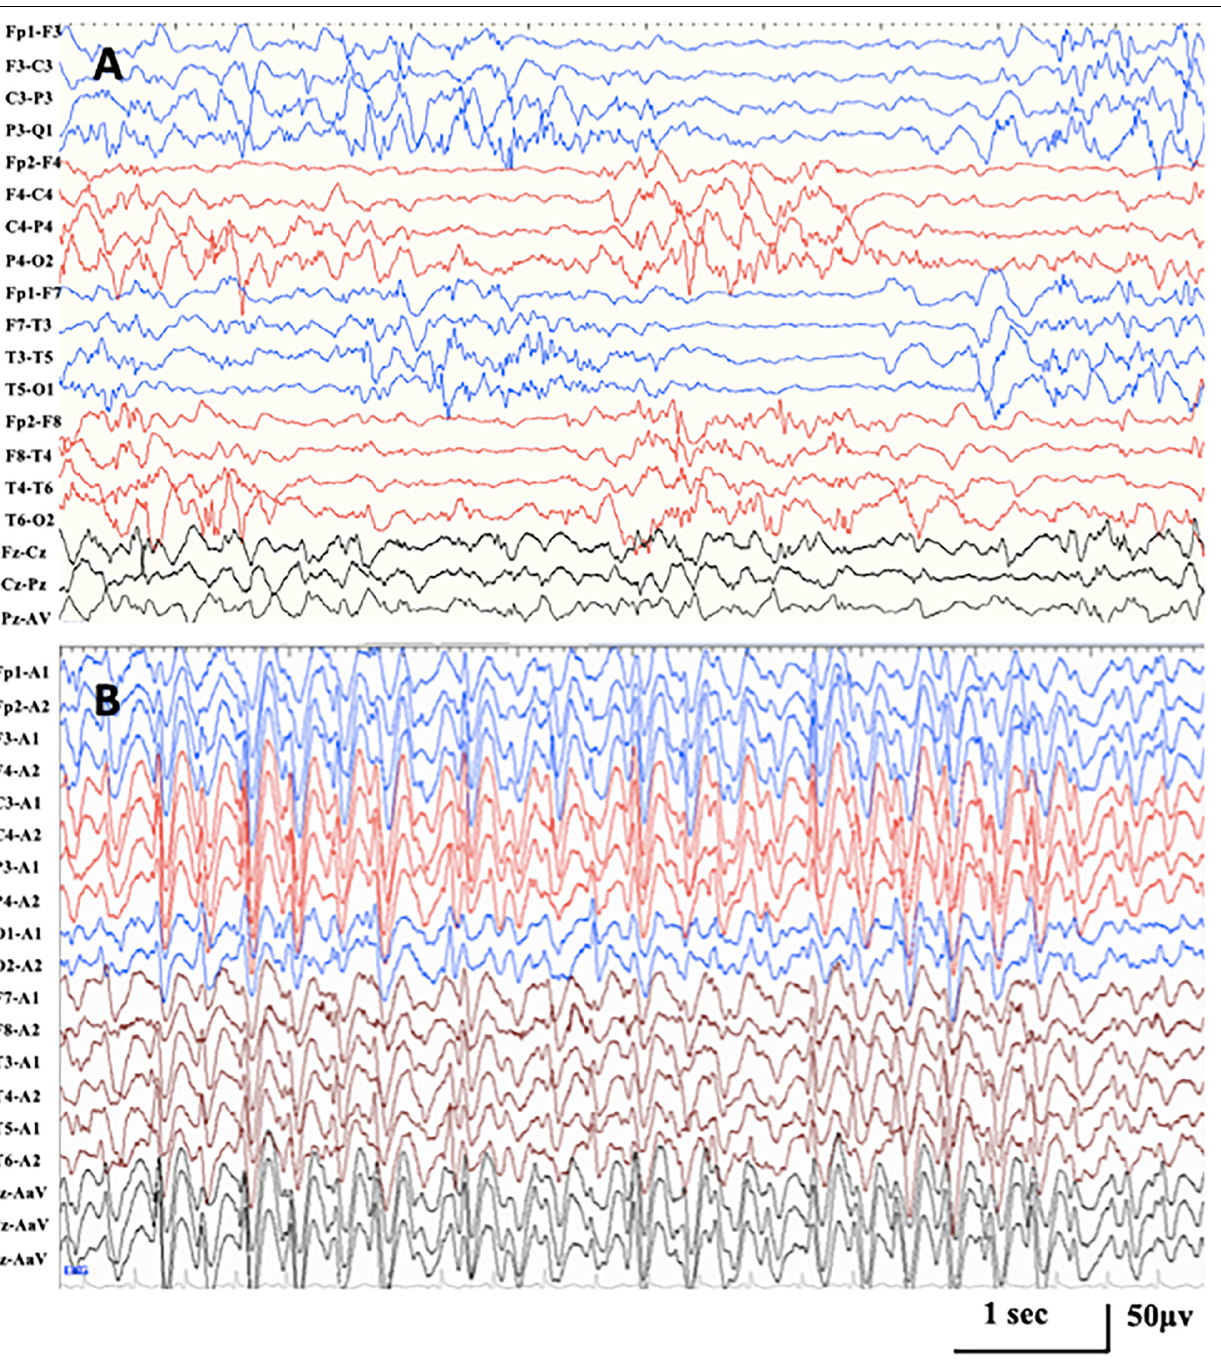
FIGURE 2 | Representative EEG in case 1 with KCNQ2- related disorders. (A) Interictal EEG at seizure onset of 1 month after birth demonstrating hypsarrhythmia with high amplitude multifocal spikes and asynchronization between hemispheres and chaotic background. (B) Interictal EEG at the age of 1.6 years, demonstrating generalized spike-and-wave with anterior predominance during NREM sleep (SWI